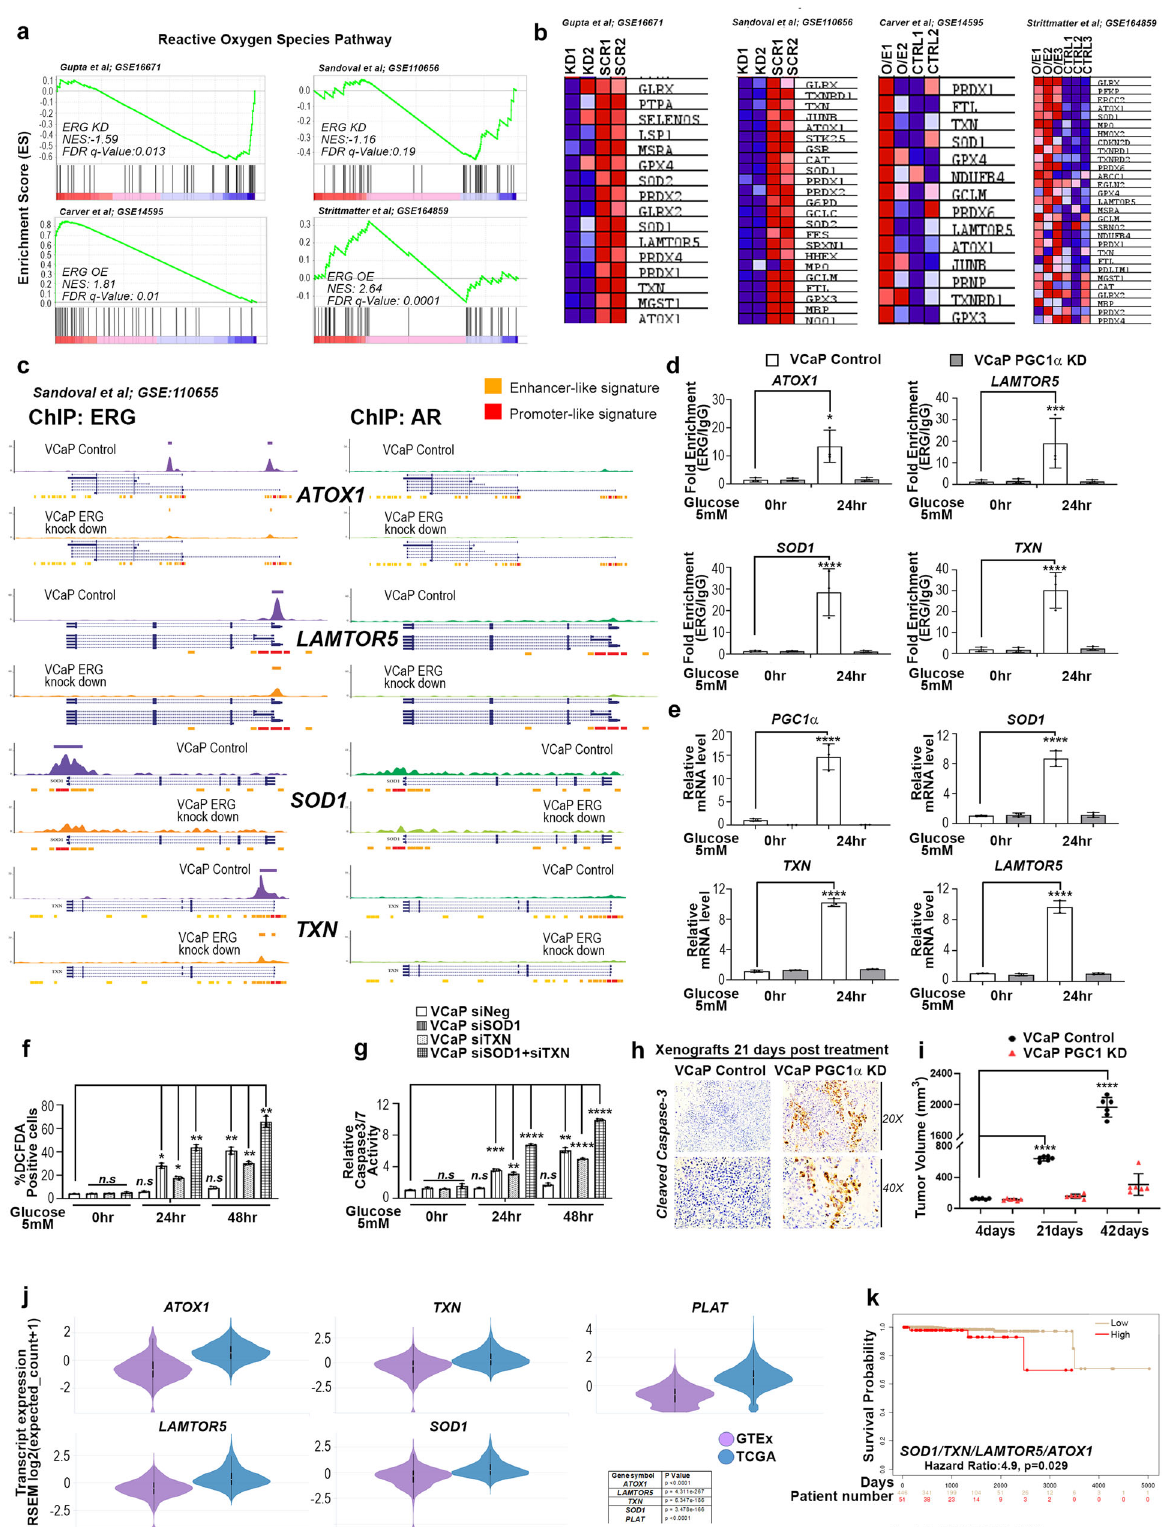
restrictions with abolished ERG-PGC1 axis might indicate a positive outcome for patients with low PGC1 α levels. Oxidative stress has been insinuated into PCa initiation, aggressiveness, castration resistance, and yet clinical interventions with antioxidant agents is not very promising 58 – 62 . Although antioxidant genes like SOD3 , TXN , and SOD1 has been